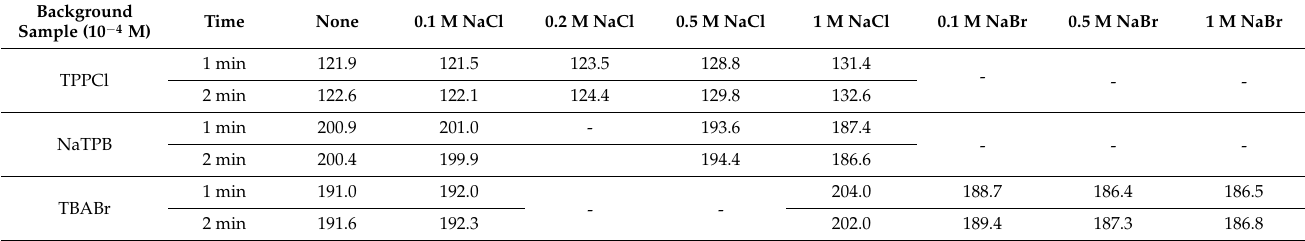
Table A4. The TBA + -, TPP + - and TPB − -selective electrodes’ potential values in solutions vs. 3.5 M Ag, AgCl reference electrode. The inner solution of an electrode contained 0.01 M NaCl; and additionally 10 − 5 /10 − 4 /10 − 3 M of the primary ion for TBA + -, TPP + - and TPB − -selective electrodes, respectively.